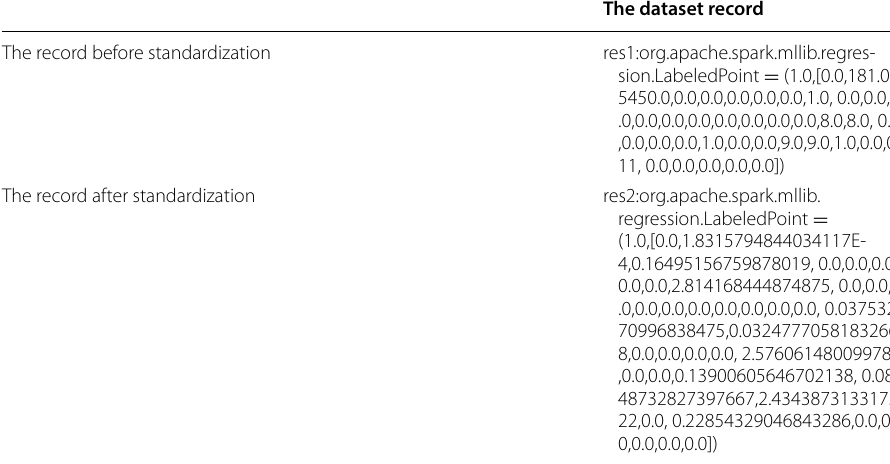
The dataset record